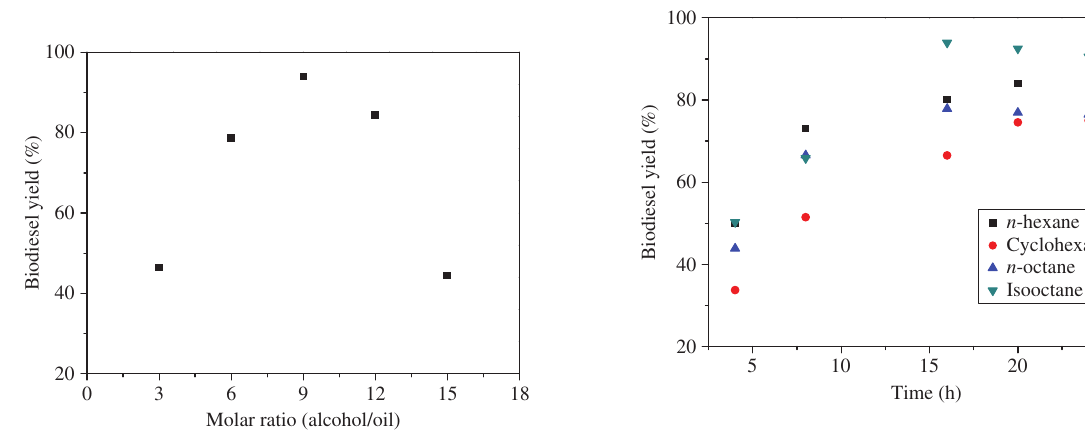
Figure 3 Effect of molar ratio on biodiesel yield [reaction condi- tions: w (molar ratio of water to surfactant) 3.5, lipase 4.4%, time 0 16 h, temperature 40 ° C, stirrer speed 250